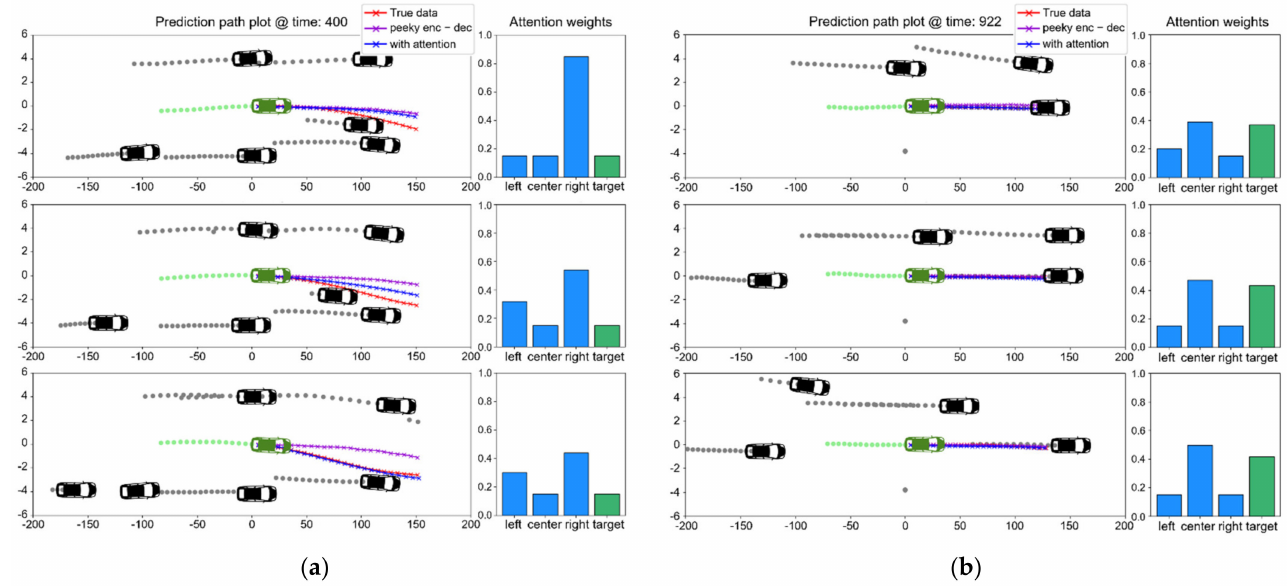
Figure 8. Examples of trajectory prediction: ( a ) lane changing and ( b ) lane